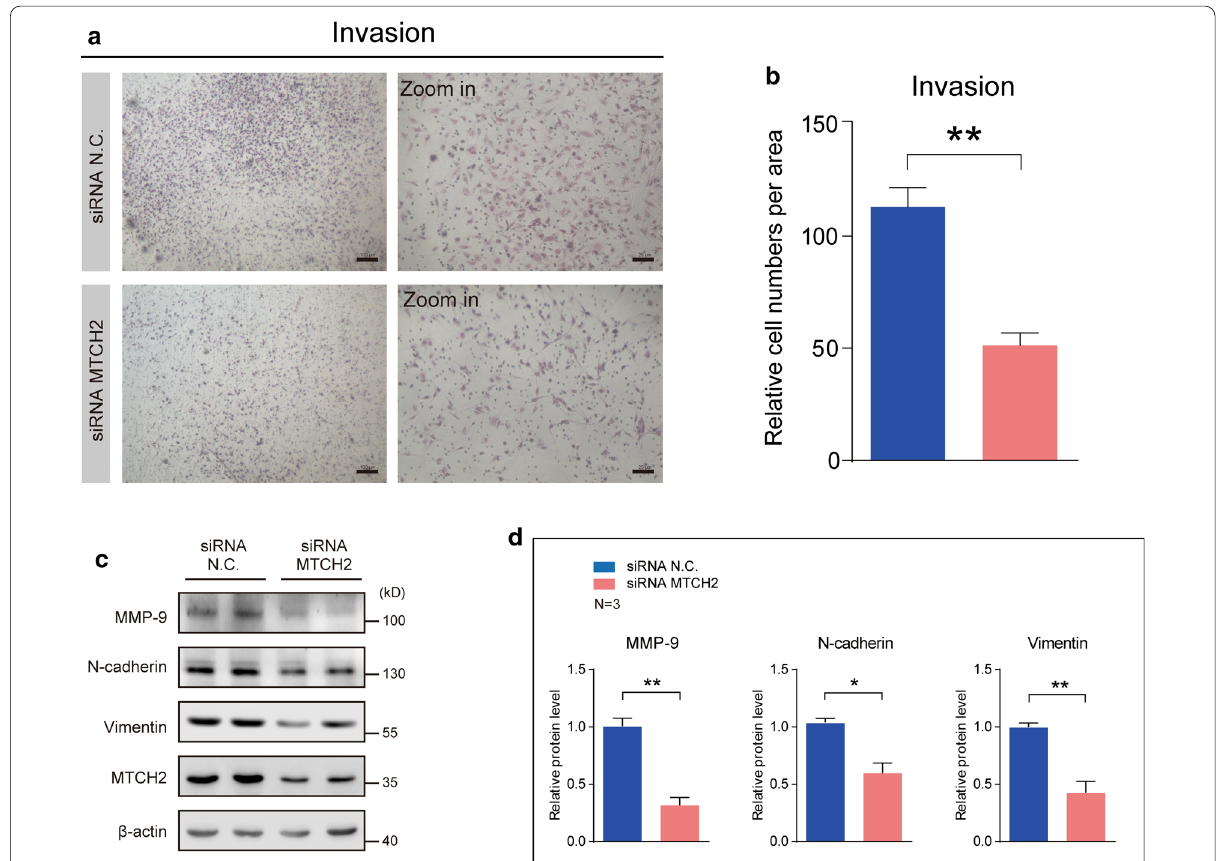
Fig. 5 MTCH2 knockdown impairs the invasion of glioma cells in vitro. a , b Images and quantifications showing that MTCH2 knockdown reduces the rate of invasion of U87 MG cells by transwell Matrigel invasion assay. c , d Western blots ( c ) and quantifications ( d ) showing the decreased protein levels of MMP-9, N-cadherin, Vimentin and MTCH2 in A172 cells (N